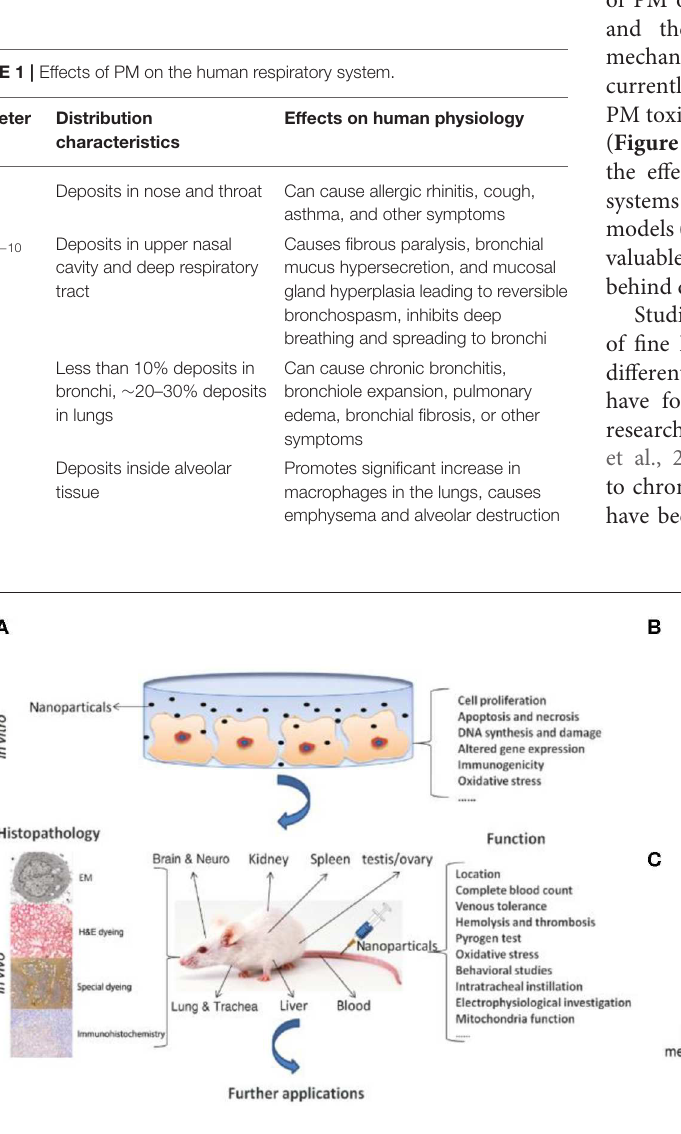
FIGURE 2 | Two main methods for elucidating the mechanisms of PM toxicity. (A) In vitro and in vivo toxicity assessment of PM. Reproduced with permission from Yang et al. (2017). (B) In vitro animal experiments exposed to aerosols mainly include nose exposure, intratracheal instillation, and oropharyngeal aspiration. Reproduced with permission from Fröhlich and Salar-Behzadi (2014). (C) Air–liquid interface (ALI) in vitro models for investigating respiratory research.